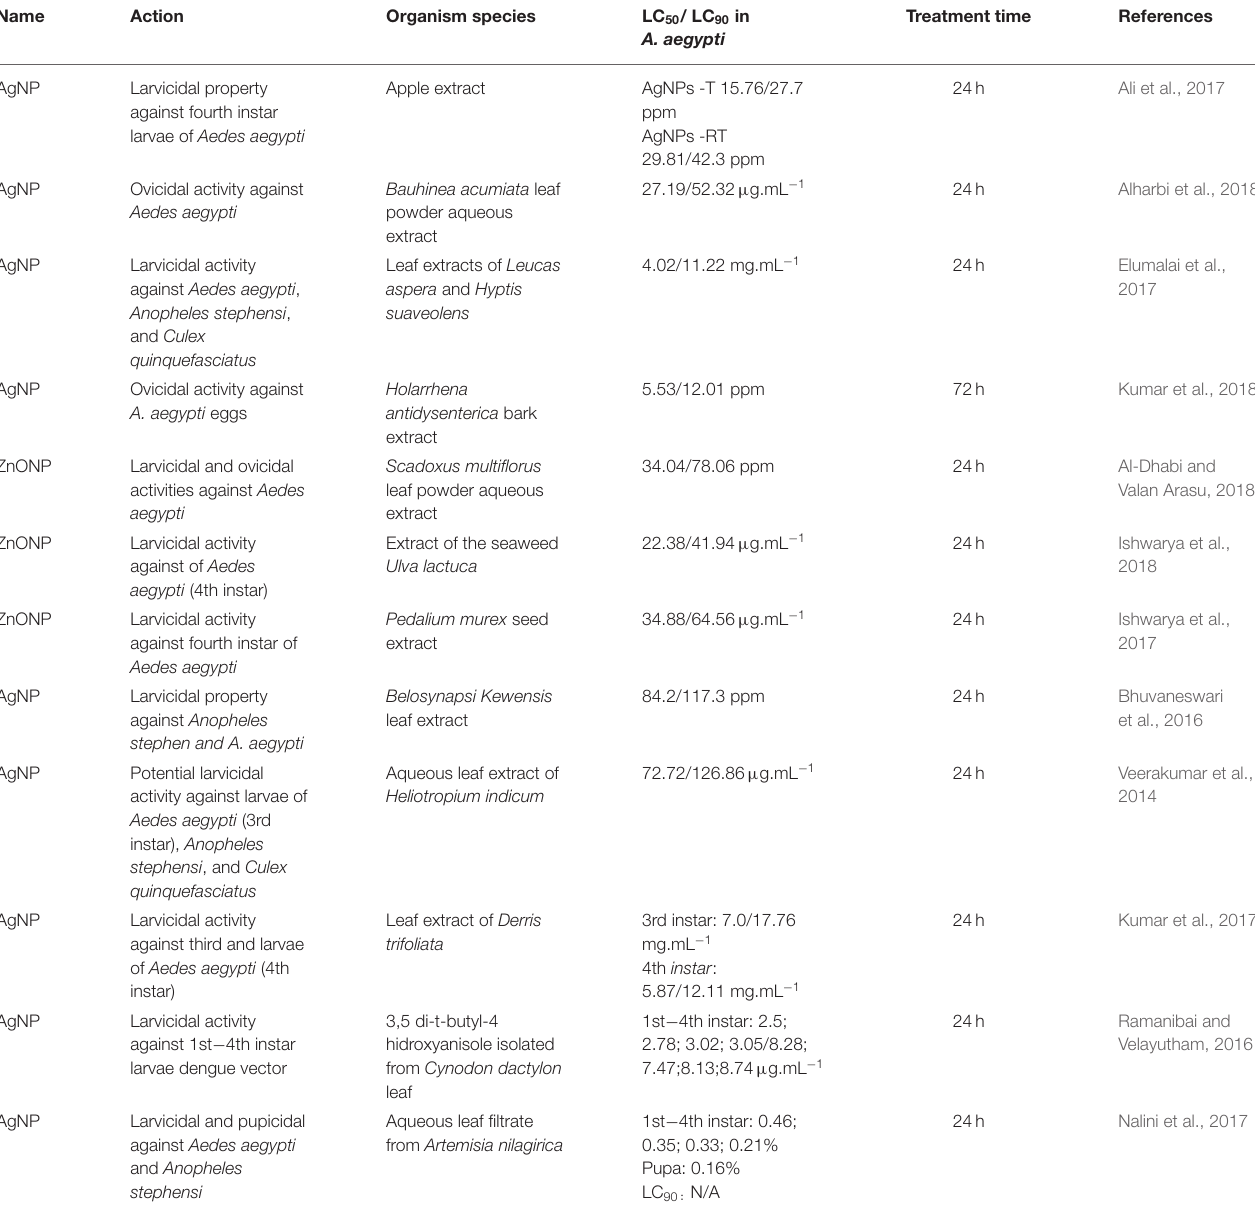
TABLE 4 | Biogenic nanoparticles tested for the control of disease